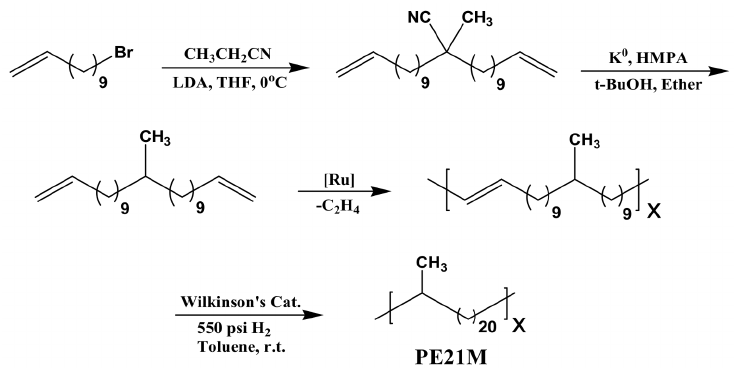
Scheme 1. Monomer and polymer synthesis